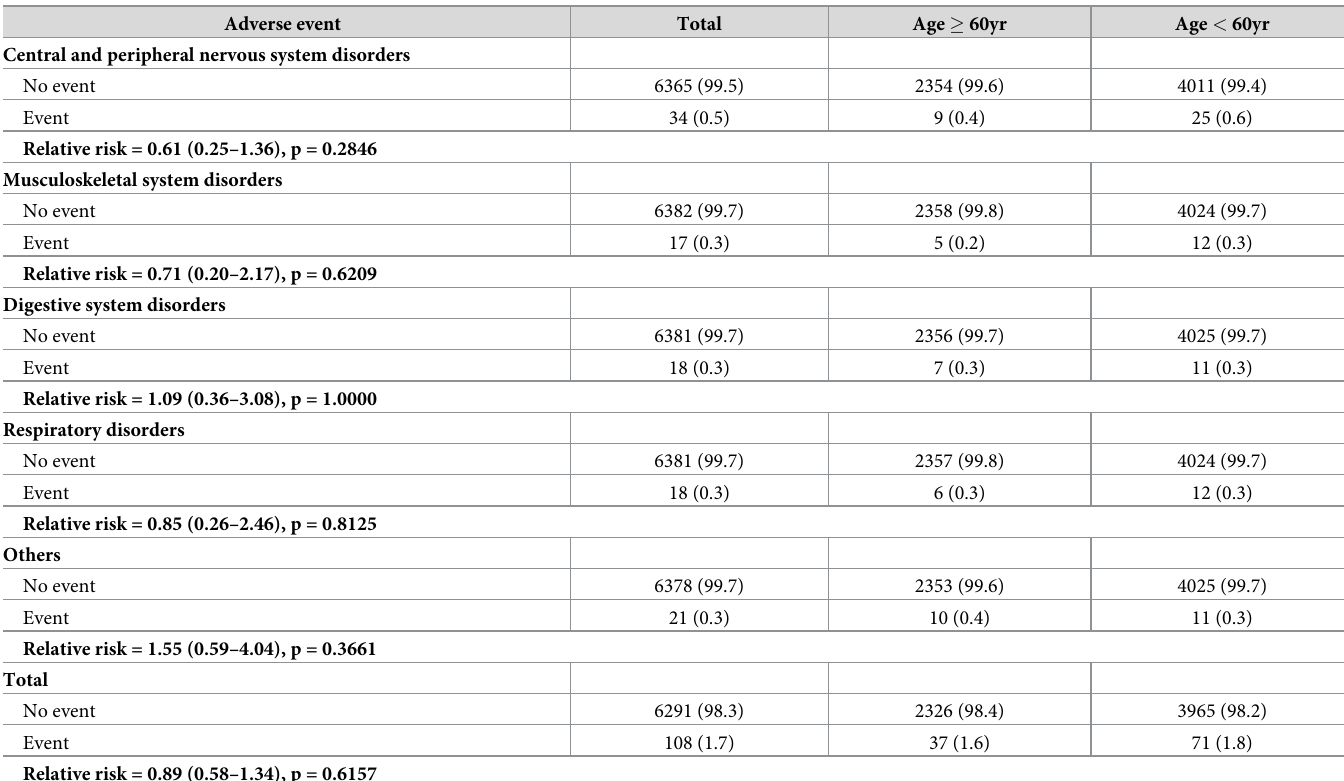
Table 4. Adverse